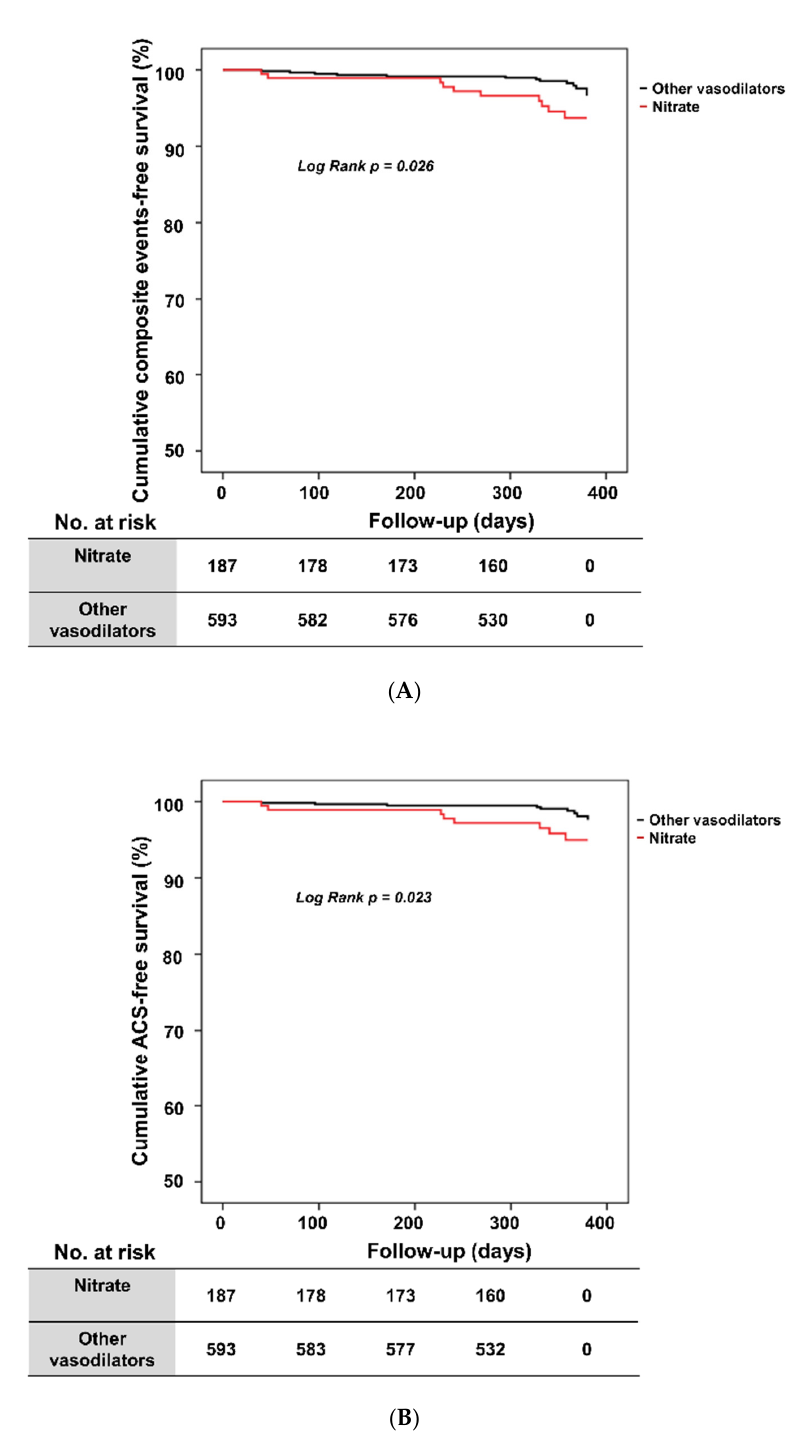
Figure 2. Kaplan–Meier survival curves of the entire population. ( A ) Cumulative composite events-free survival according to vasodilator. ( B ) Cumulative ACS-free survival according to vasodilator. ACS, acute coronary syndrome.